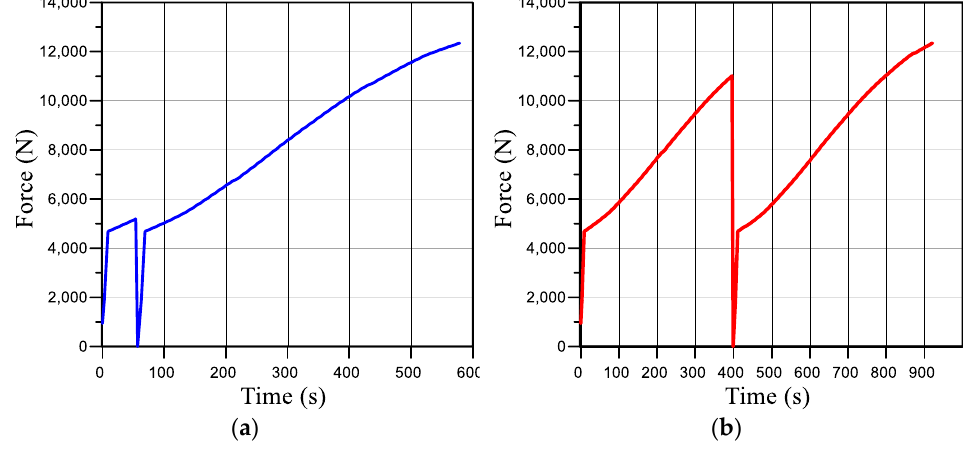
Figure 4. Sample loading diagram for modes ІІ ( а ) and ІІІ ( b ).